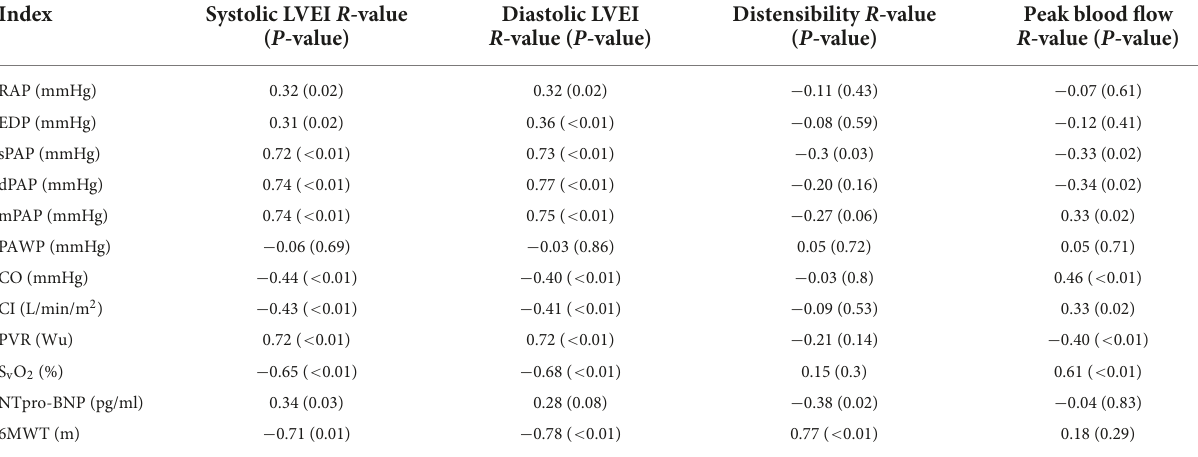
TABLE 4 Spearman correlation of standard pulmonary hypertension indices vs. novel cardiac MRI indices.